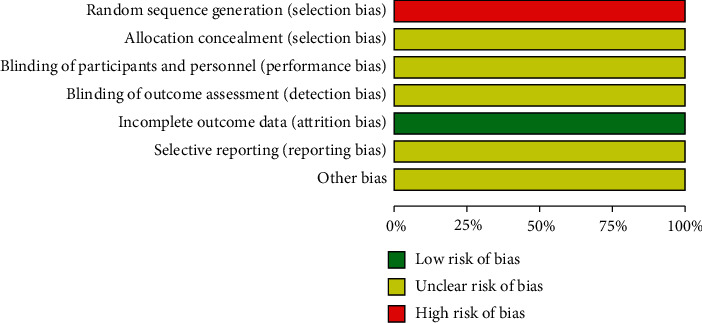
Risk of bias graph.